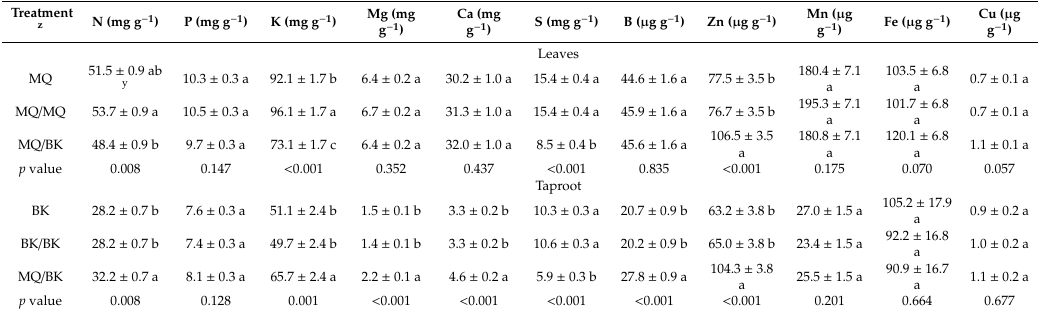
Table 5. Mineral nutrient concentrations in leaves of grafted, self-grafted, and non-grafted pac choi and in taproots of grafted, self-grafted, and non-grafted daikon radish plants at harvest in the 2019 experiment.